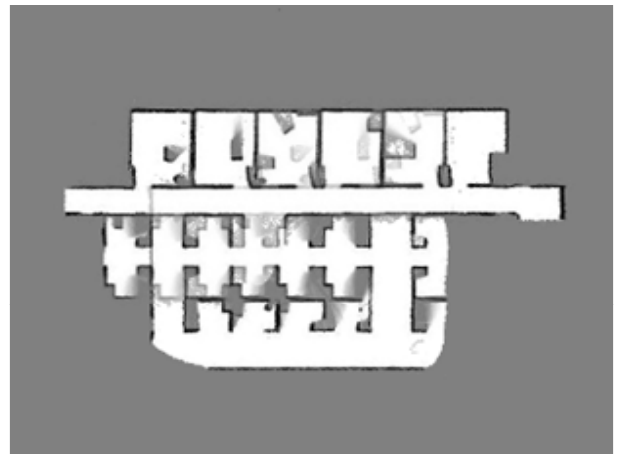
Fig. 8. The failed merging of map 1+2 and map 3 (best hypothesis acceptance indicator